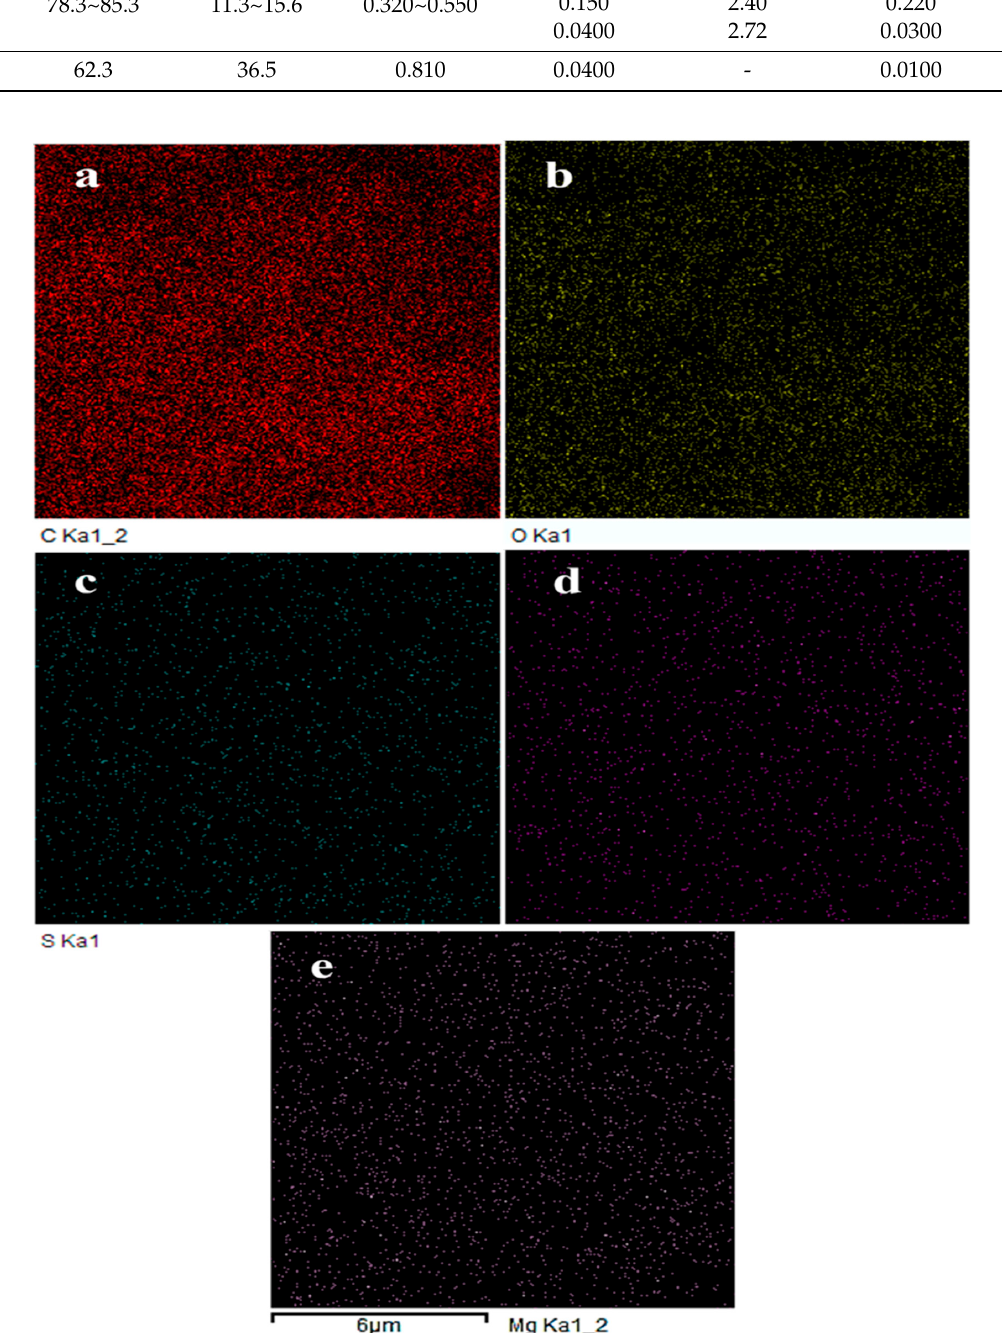
Figure 3. Elemental mapping of CPP200: ( a ) C; ( b ) O; ( c ) S; ( d ) Ca; and ( e ) Mg. The FT-IR spectra of BCs are shown in Figure 4. CPP200–CPP350 produced at low temperatures preserved most of carbohydrate components of the raw biomass. In the py- rolysis temperature range of 200–350 °C, no obvious changes could be observed in the FT- IR spectra. The peaks at 3337 cm − 1 correspond to the stretching vibration of O–H [30]; the absorption bands at 2925 and 2846 cm − 1 correspond to the C–H stretching vibrations of alkyl groups [31]; the stretching vibrations of –C=O of aldehydes or esters appear at vari- ous wave numbers in the range of 1511~1712 cm − 1 [32]; the skeletal vibrations of the O–H plane could be observed at 1456 cm − 1 ; the peaks appearing at 1317~1368 cm − 1 and 1030~1225 cm − 1 could be attributed to the C–O and C–O–C stretching vibrations, respec- tively [33]. The FT-IR results suggest that BCs retain a large number of original compo- nents, such as fatty acids, sugars, lignin and polar cellulose-containing molecules [34]. As